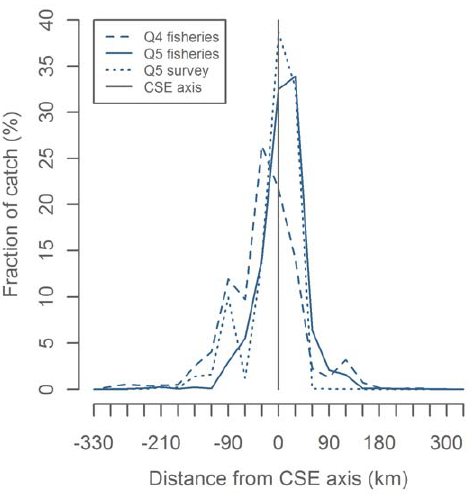
Figure 6. Distance from catch position to continental shelf edge (CSE) axis. Positive values are off the shelf. In the North Sea positive values are northeast of the axis.